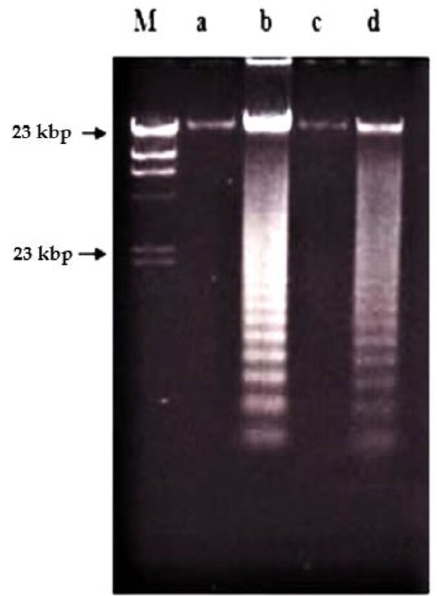
Figure 11. The involvement of RNA synthesis in damnacanthal-induced apoptosis in CEM-SS cells at 24 h. Actinomycin D failed to prevent apoptosis induced by 30 μg/mL of damnacanthal at 24 h. Lane a: control. Lane b: damnacanthal (30 μg/mL). Lane c: actinomycin D (10 μg/mL). Lane d: damnacanthal (30 μg/mL) + actinomycin D (10 μg/mL). Lane M: Marker (HindIII digest of lambda DNA).